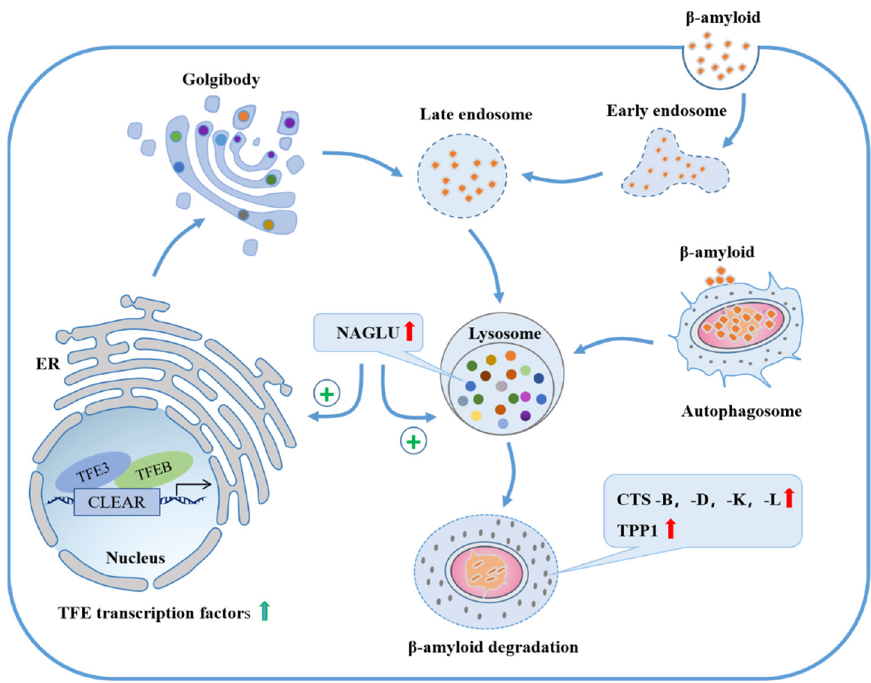
Figure 7. The functional model of NAGLU . A possible mechanism of NAGLU promoting the degradation of A β 42 by enhancing the lysosomal pathway.